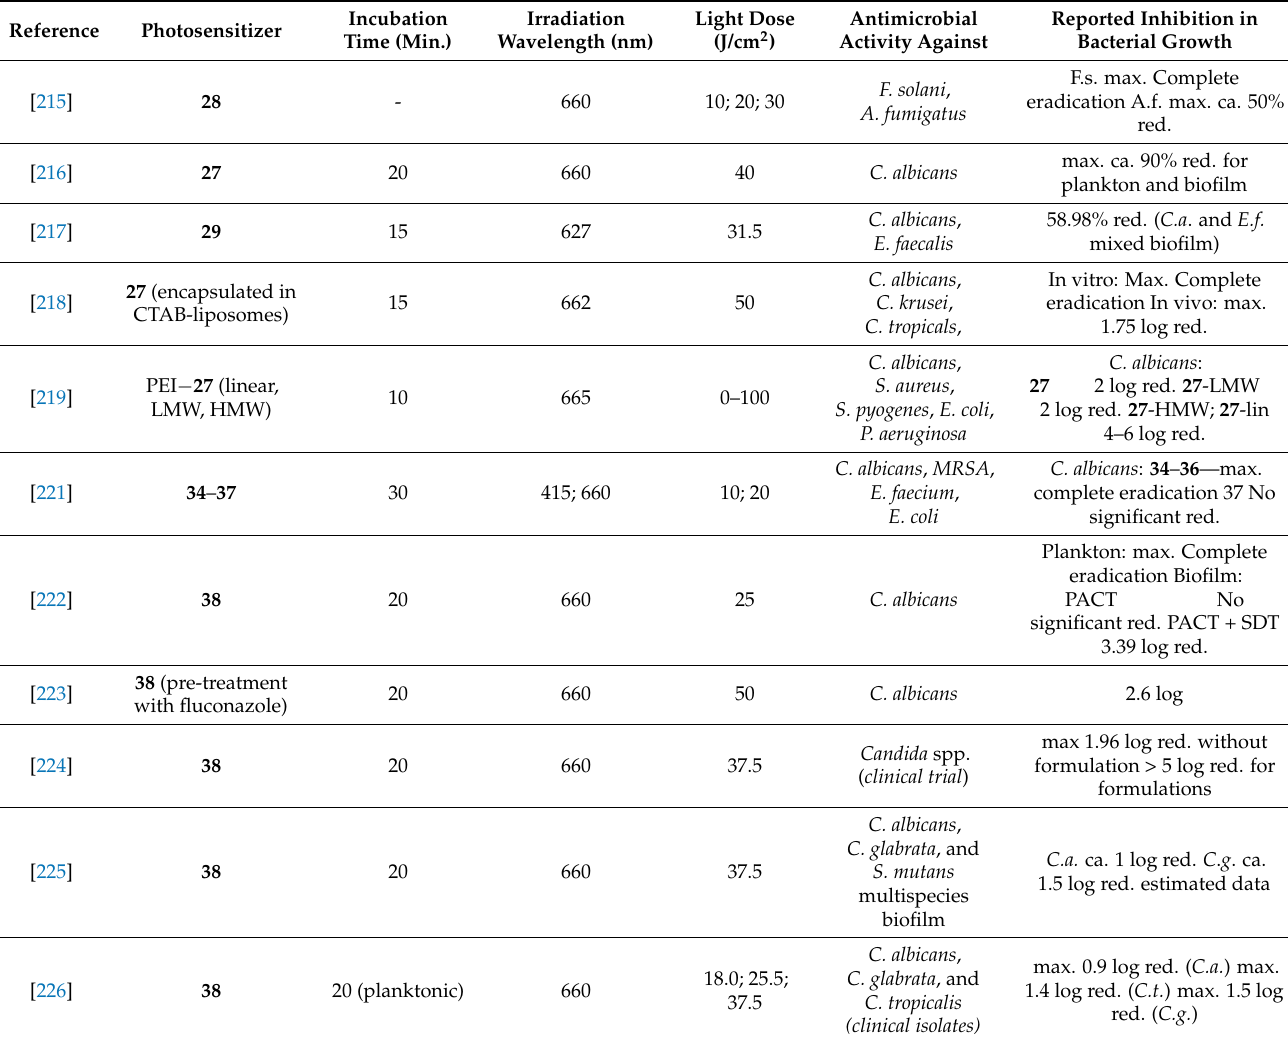
Table 5. Chlorins—photodynamic antimicrobial activity and